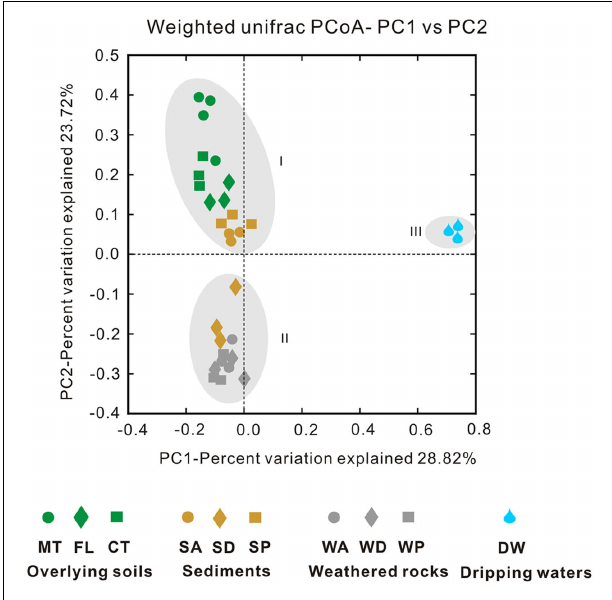
FIGURE 6 | Principal coordinate analysis (PCoA) plot based on weighted Unifrac results among samples collected from the Heshang Cave ecosystem. Samples colors are the same as previous figures, and abbreviations are described in Figure 1